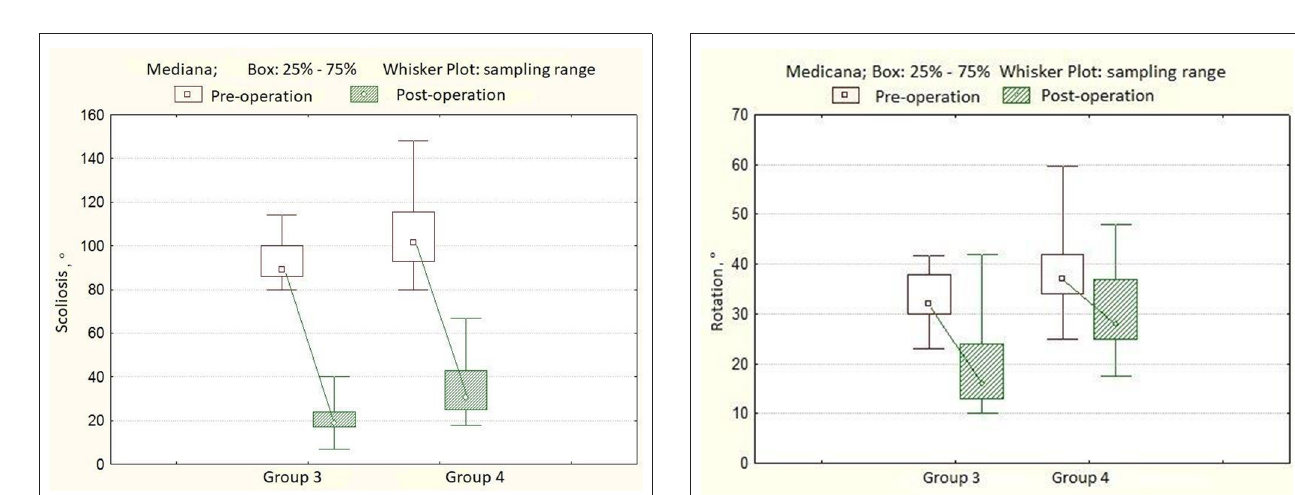
FIGURE 3 | A boxplot showing the dynamics of scoliosis angles in patients from groups 3 and 4.